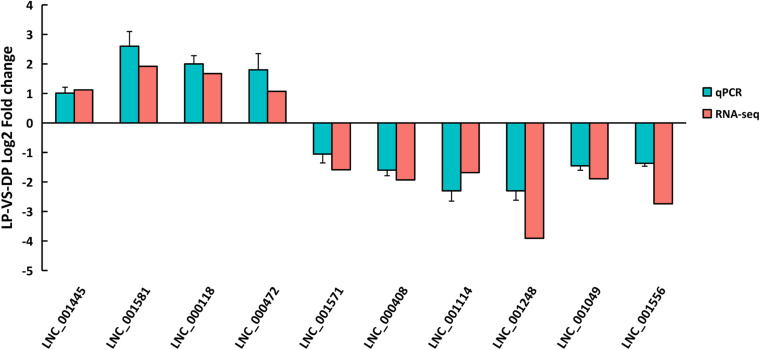
Validation and comparison of log2(fold change) in ten DELs between qRT-PCR and RNA-Seq.